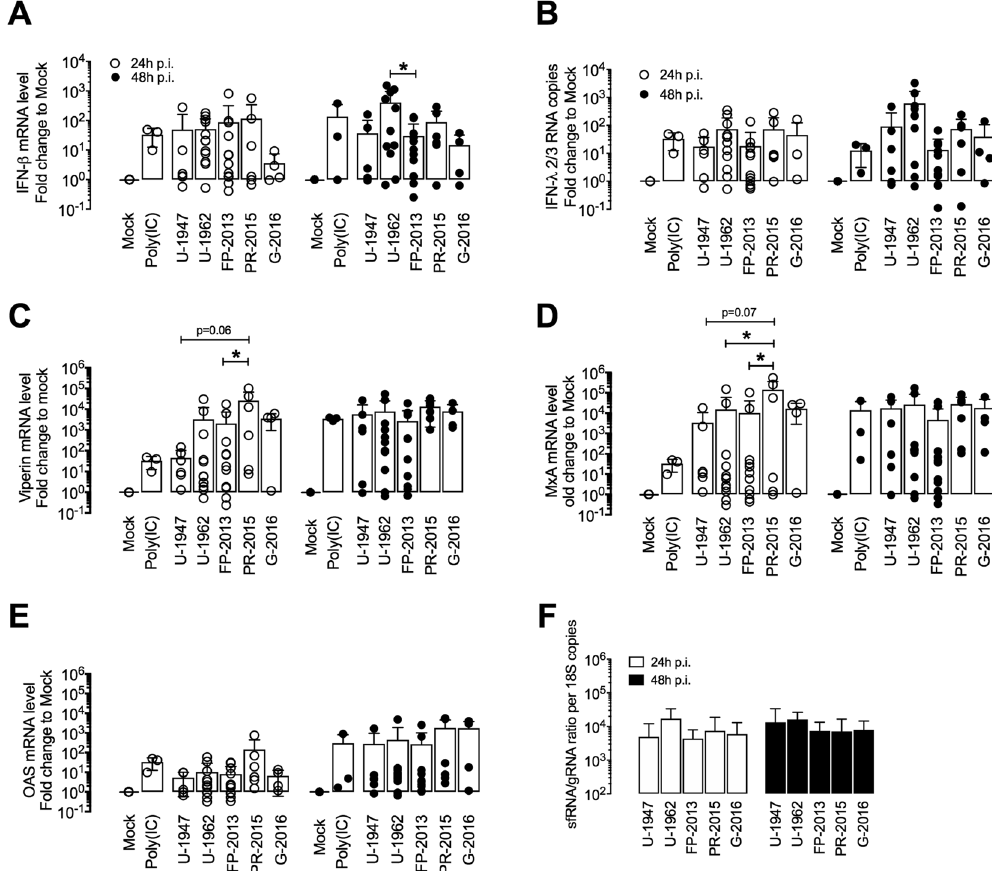
Figure 5. IFN type I/III and ISG responses induced by MoDCs upon ZIKV infection. Fold change of gene expression levels relative to mock of IFN- β ( A ) and IFN- λ 2/3 ( B ) measured by quantitative RT-PCR in MoDCs 24, and 48 h p.i. with five ZIKV strains at a MOI of 0.1 TCID 50 /cell and after addition of Poly(IC) and Resiquimod. Fold change of gene expression levels of selected ISGs, namely Viperin ( C ), MxA ( D ), and 2 ′ ,5 ′ - OAS ( E ) in MoDCs infected with five ZIKV strains at a MOI of 0.1 TCID 50 /cell and after addition of Poly(IC) and Resiquimod. ( F ) Measurement of sfRNA to gRNA ratios by quantitative RT-PCR in MoDC cultures 24, and 48 h p.i. with five ZIKV strains at a MOI of 0.1 TCID 50 /cell. Data are presented as mean + / − SD of MoDCs generated from 4–12 independent blood donors. Differences among strains were tested with one-way ANOVA with Tukey correction for multiple comparisons. Stars indicate significance levels; * p <